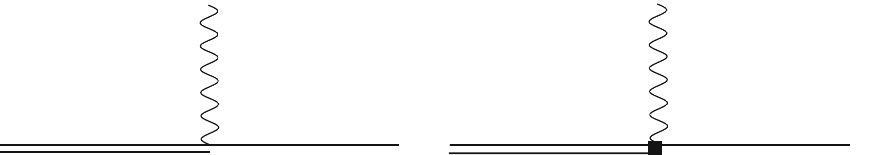
Fig. 1 The O ( p 2 ) and O ( p 4 ) tree level diagram where the decuplet (octet) baryon is denoted by the double (single) solid line. The left dot and the right black square represent second- and fourth-order couplings respectively